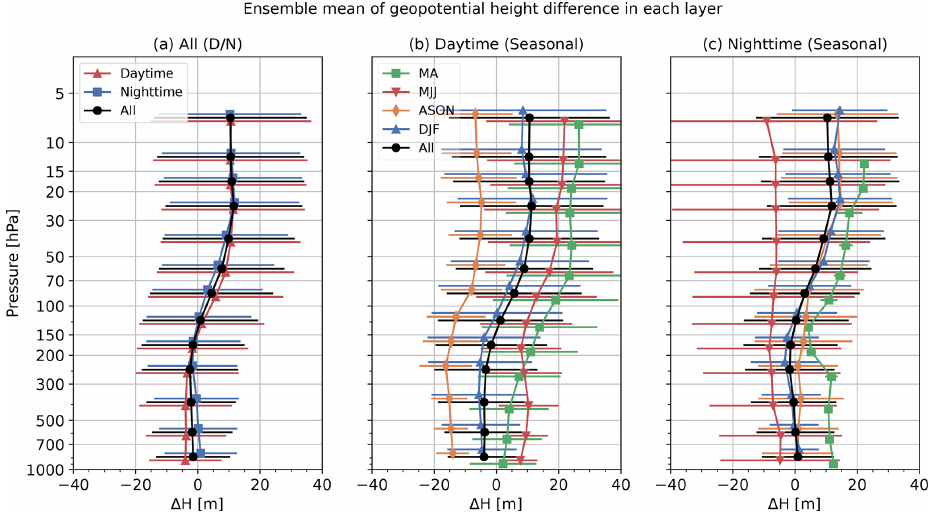
Figure 27. As per Fig. 18 but for geopotential height.